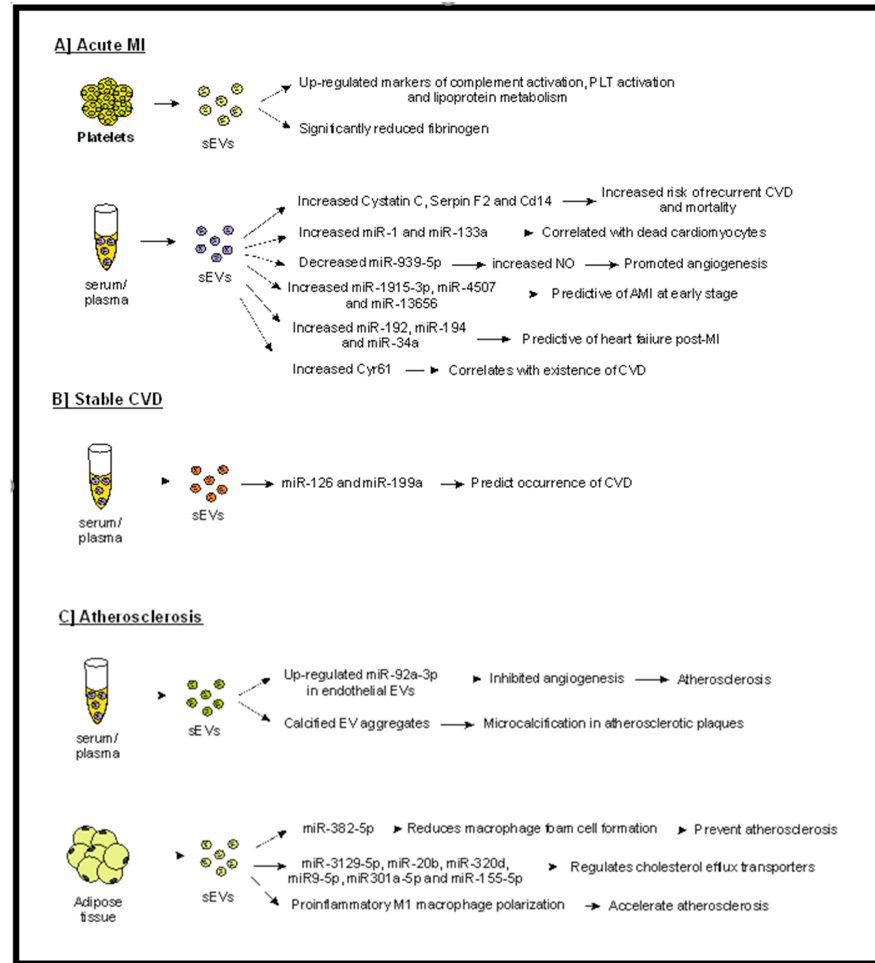
Figure 2. Possible predictive role of sEVs in acute MI ( A ) in stable CVD ( B ) and in the generation of atherosclerotic plaques. ( A ) sEVs isolated from serum or plasma of patients with acute MI have been shown to carry various markers, such as miRNAs, cystatin C, serpin F2, CD14, and Cyr-6, that correlate with increased morbidity (e.g., heart failure, dead cardiomyocytes, CVD). Furthermore, factors associated with bad outcomes (such as complement activation and lipoprotein metabolism) have been detected in platelet-derived sEVs in patients with acute MI. ( B ) In patients with stable CVD, certain sEV-miRNAs can predict the progression of disease. ( C ) sEVs have been proven to participate in generation of atherosclerotic plaques, whereas adipose-derived sEVs have been shown to contribute to atherosclerosis development and progression. Abbreviations: sEVs: small extracellular vesicles, PLT: platelets, AMI: acute myocardial ischemia, CVD: cardiovascular disease, Cyr-61: cysteine-rich angiogenic inducer